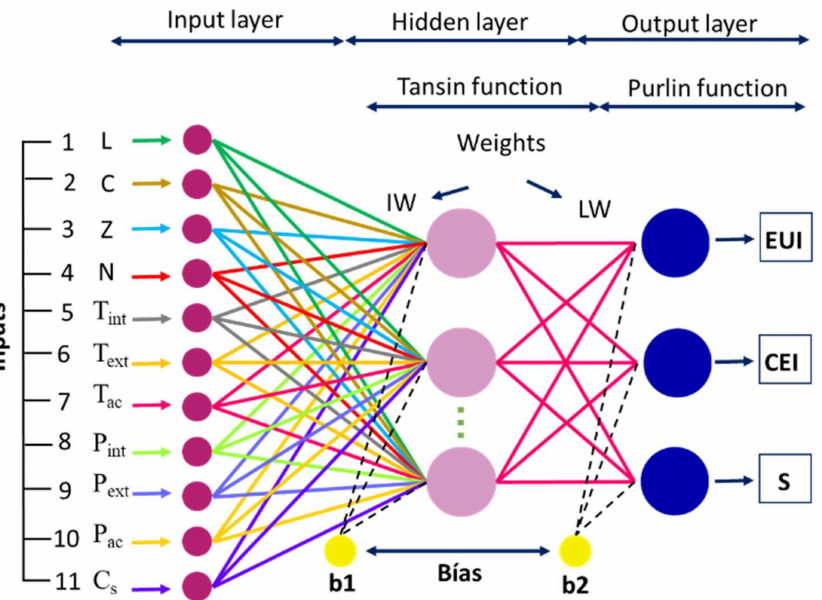
Figure 4. ANN architecture for the digital-twin development that simultaneously estimates the three indicators based on the 11 parameters of interest in